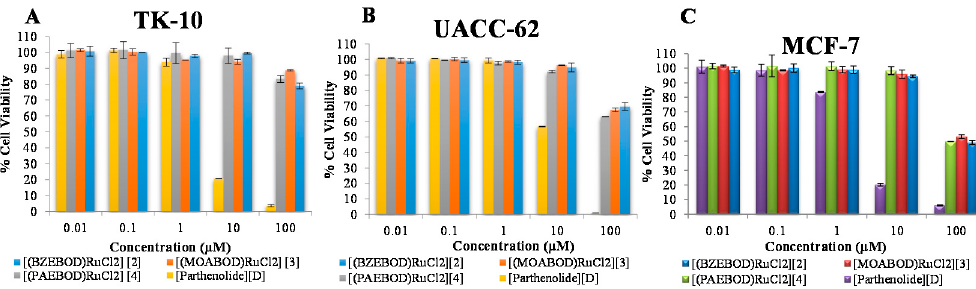
Figure 3. Antiproliferative measurements of heterocyclic ruthenium(III) complexes graphs [2–4], parthenolide [D] in A – C representing cell viability charts for the corresponding Ru(III) complexes against the selected cancer cell lines. ( A ) Human renal cancer cell (TK-10); ( B ) Human melanoma cancer cell (UACC-62); ( C ) Human breast cancer cell (MCF-7).